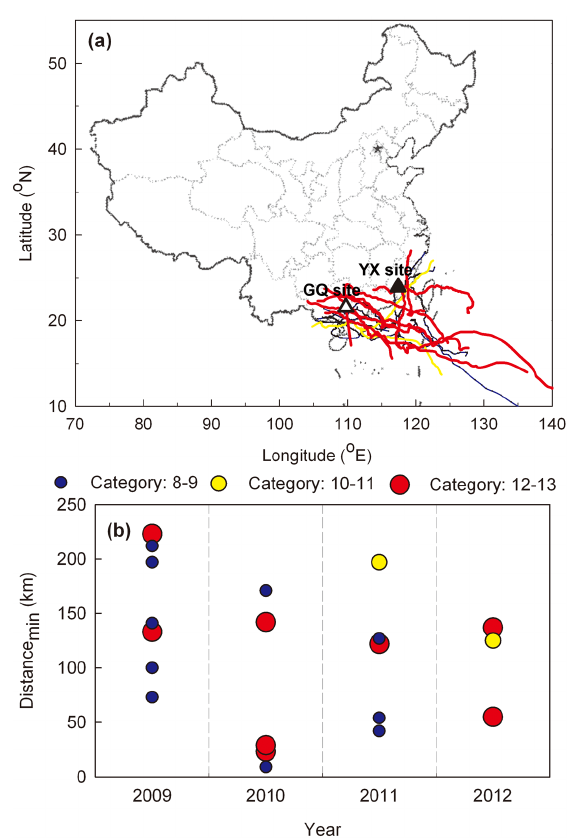
Figure 1. (a) Paths of the 19 typhoons that passed over Yunxiao (YX) and Gaoqiao (GQ) mangrove sites during a 4-year period be- tween 2009 and 2012, and (b) category of each typhoon and its distance min (the minimum distance from mangrove sites) during 2009 and